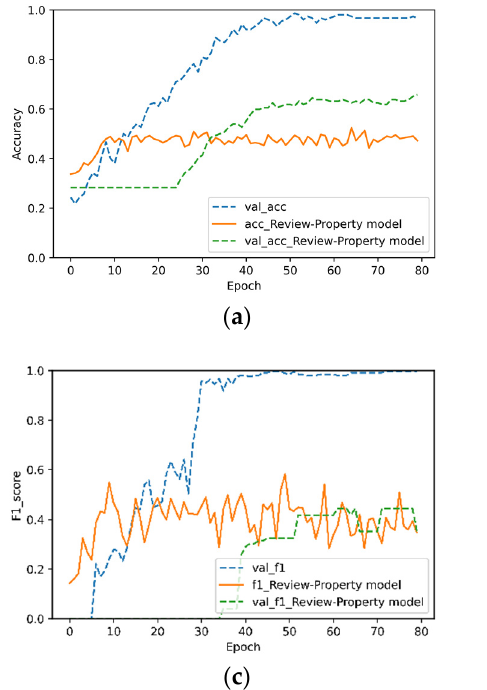
Figure 8. Experimental results of the video–property model: ( a ) accuracy, ( b ) recall, and ( c ) F 1 score.